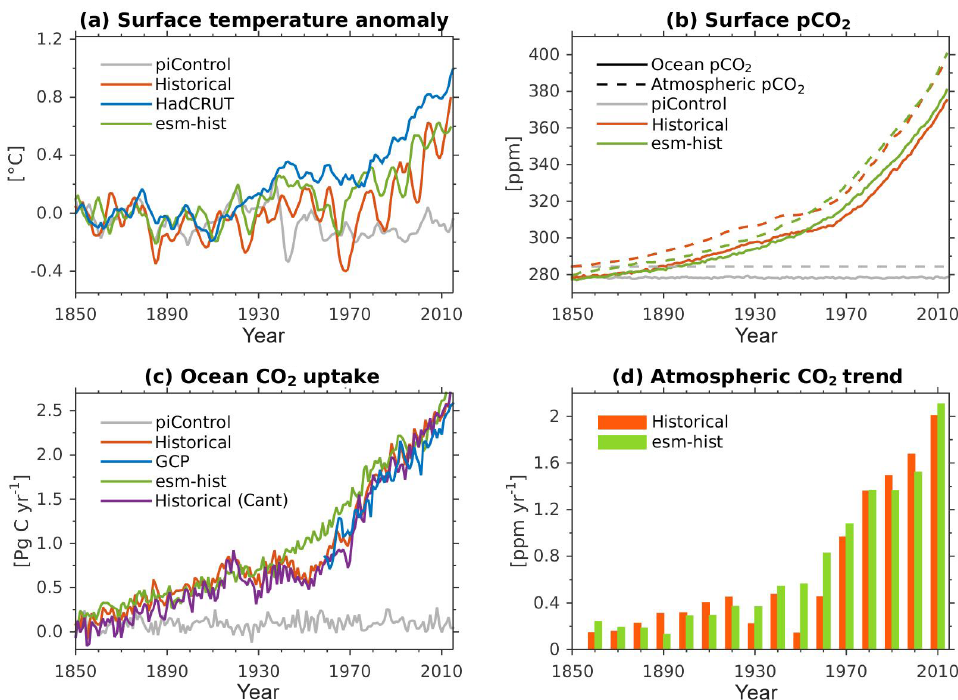
Figure 20. Time series of global mean annual (a) surface air temperature anomalies relative to the 1850–1879 period, (b) surface ocean and atmospheric p CO 2 , (c) ocean CO 2 uptake, and (d) atmospheric CO 2 growth rate. Shown are values from the NorESM2-MM (grey) pre-industrial control and (orange) historical simulations. Green depicts results from the emissions-prescribed historical simulation with NorESM2-LM. The purple line in panel (c) represents the anthropogenic carbon uptake estimated by subtracting the natural carbon uptake from the total uptake (see also Sect. 3.2). Data for temperature and ocean carbon sinks (in blue) are estimates from HadCRUT4 and the Global Carbon Project (Morice et al., 2012; Le Quéré et al., 2018),